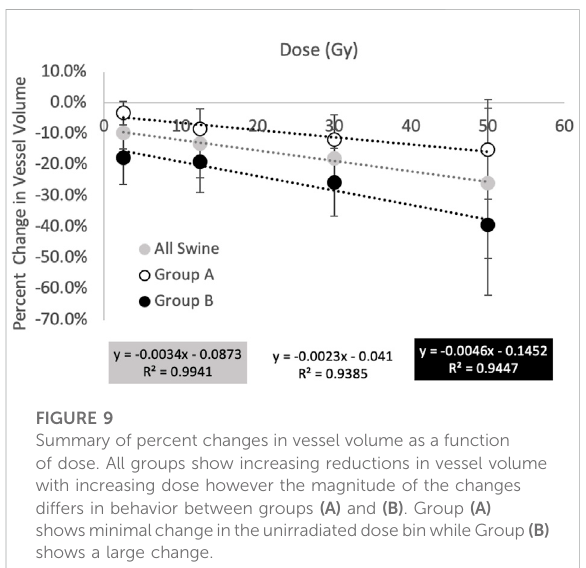
FIGURE 9 Summary of percent changes in vessel volume as a function of dose. All groups show increasing reductions in vessel volume with increasing dose however the magnitude of the changes differs in behavior between groups (A) and (B) . Group (A) showsminimalchangeintheunirradiateddosebinwhileGroup (B) shows a large change.